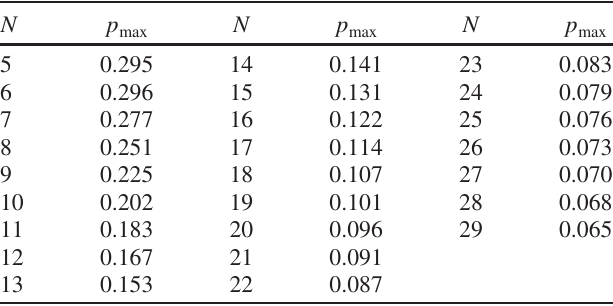
TABLE I. Robustness of nonlocality to white noise in the case of the W state, reported as a function of N .